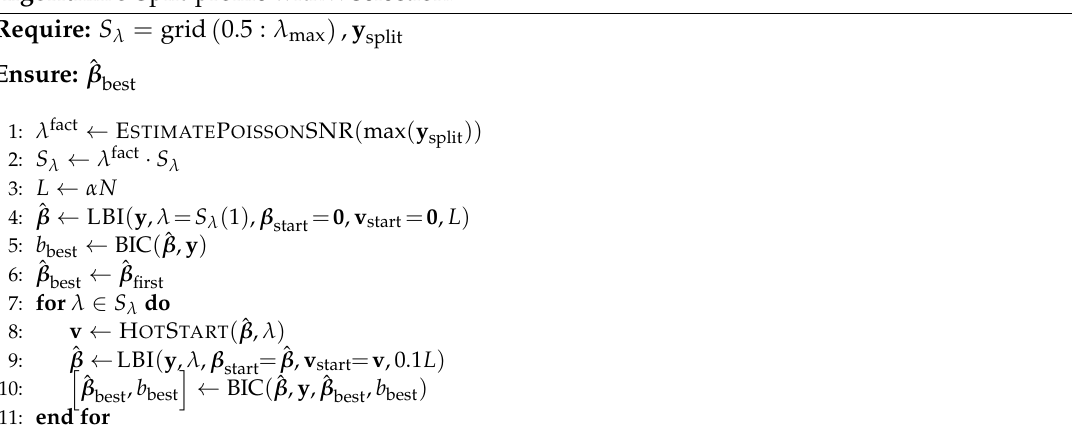
Algorithm 3 Split-profile with λ